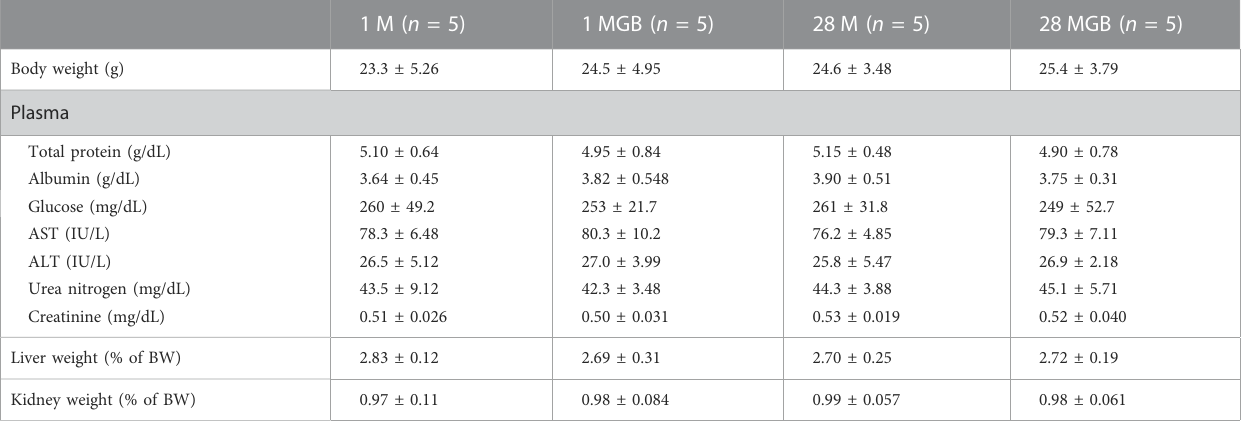
TABLE 3 Mean (±SD) body weight, physical chemistry, and weights of liver and kidneys in 1 M, 1 MGB, 28 M and 28 MGB groups,